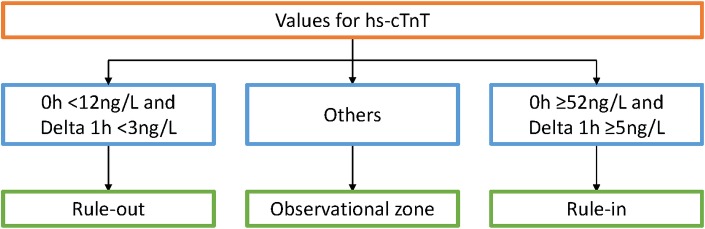
One-hour rule-out and rule-in Algorithm [16, 17].